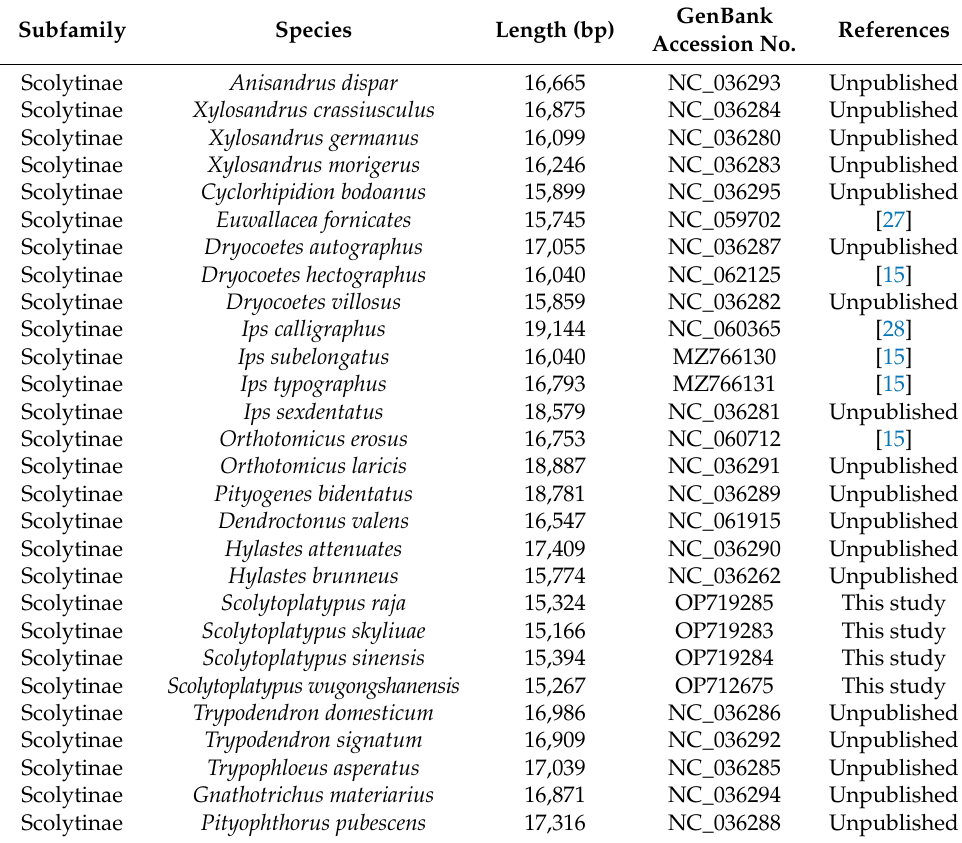
Table 2. Mitochondrial genome information used in this